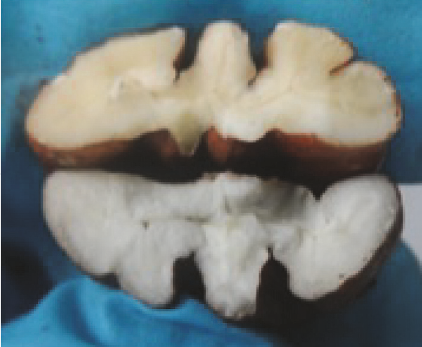
Figure 9: Image showing the contrast between (top) opalescent and (bottom) nonopalescent pecan nuts.